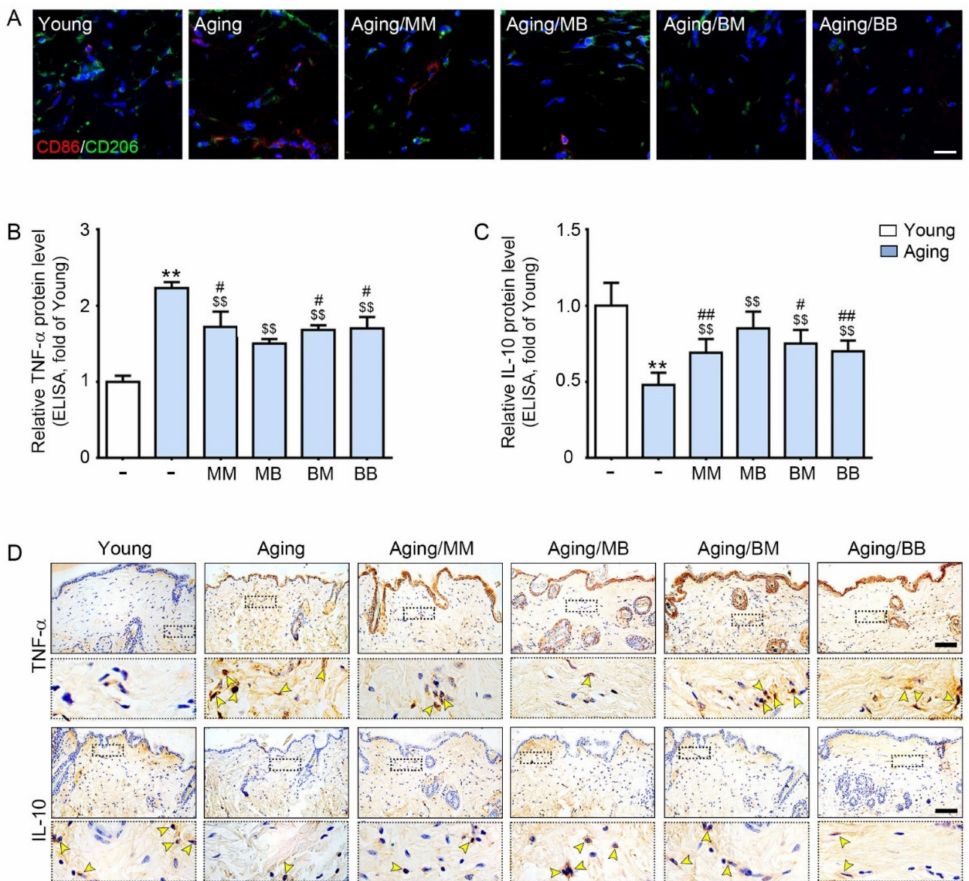
Figure 2. The modulating effect of M1/M2, TNF- α , and IL-10 depending on the considered combina- tions of RF modes: ( A ) Double-stained confocal microscopic images showing the expression of M1 (CD86, red) and M2 (CD206, green) markers. Nuclei were stained blue using DAPI (scale bar = 100 µ m). ( B , C ) ELISA was used to determine the protein expression levels of ( B ) TNF- α and ( C ) IL-10 in the skin tissue. ( D ) TNF- α and IL-10 expression in the dermis of the aged mice skin was assessed immunohistochemically (scale bar = 100 µ m). The yellow arrows point to positive signals. Data are presented as mean ± SD. **, p < 0.01, vs. Young; $$, p < 0.01, vs. Aging; #, p < 0.05 and ##, p < 0.01, vs. Aging/MB (Mann–Whitney U test). MM, monopolar mode applied twice; MB, application of monopolar mode followed by application of the bipolar mode; BB, bipolar mode applied twice; BM, application of the bipolar mode followed by application of the monopolar mode; CD86, cluster of differentiation 86; CD206, cluster of differentiation 206; DAPI, 4 (cid:48) ,6-diamidino-2-phenylindole; TNF- α , tumor necrosis factor-alpha; IL-10,